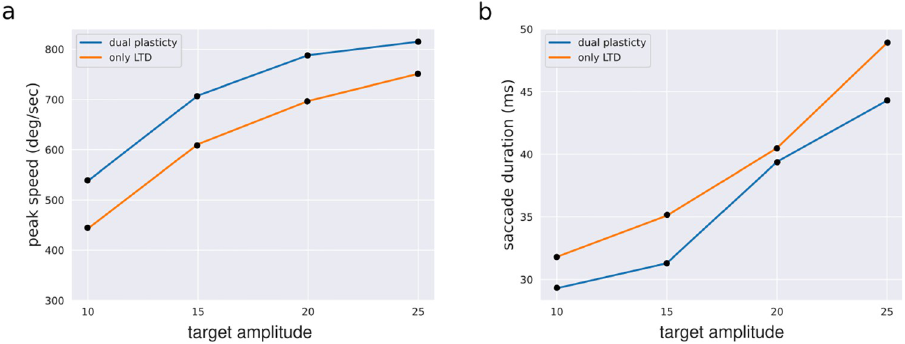
Fig 3. Exemplary saccade kinematics across different target amplitudes. a) Peak speed against target amplitude. b) saccade duration against target amplitude, tested at four different target amplitudes at 10, 15, 20, 25 degrees using cerebellum models with dual plasticity and only